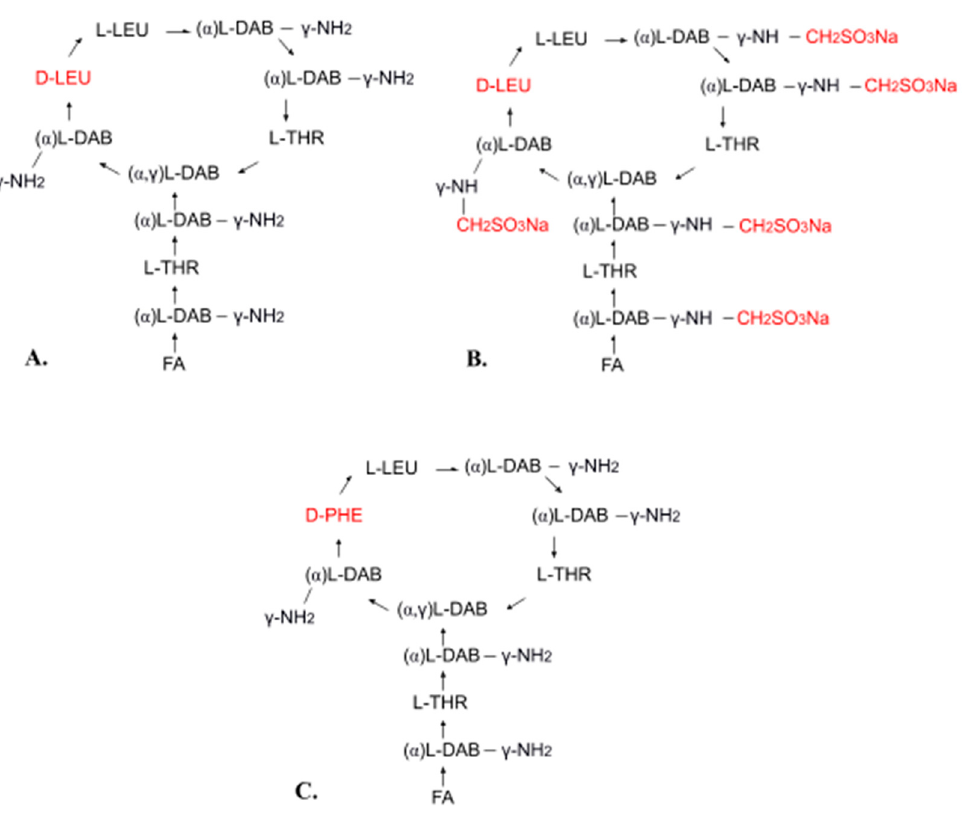
Figure 1. Chemical structure of polymyxin E ( A ), sodium colistimethate ( B ), and polymyxin B ( C ): FA—fatty acid, THR—threonine, LEU—leucine, DAB— α , γ -diaminobutyric acid, PHE—phenylalanine, α and γ indicate the amino groups forming the peptide linkage.